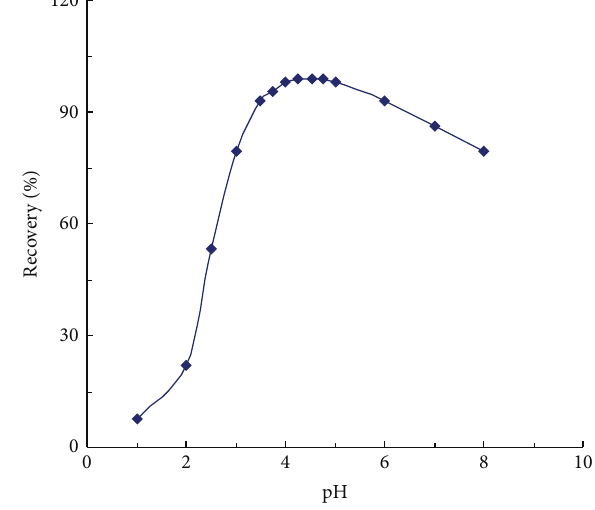
Figure 4: Effect of pH on the recovery percent of U(VI) using 100mL of model solutions of 100 𝜇 gL −1 U(VI) containing 0.150g of the EIR at 298 ± 1